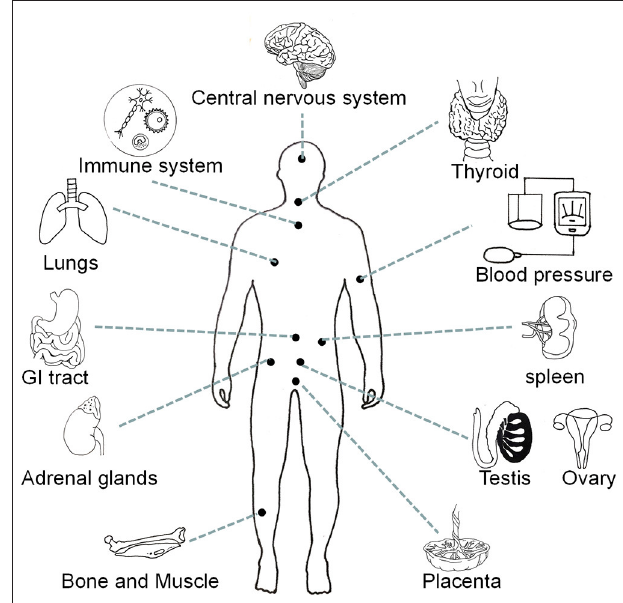
FIGURE 1 | Distribution map of NMU expression in multiple organs and tissues of the human body.